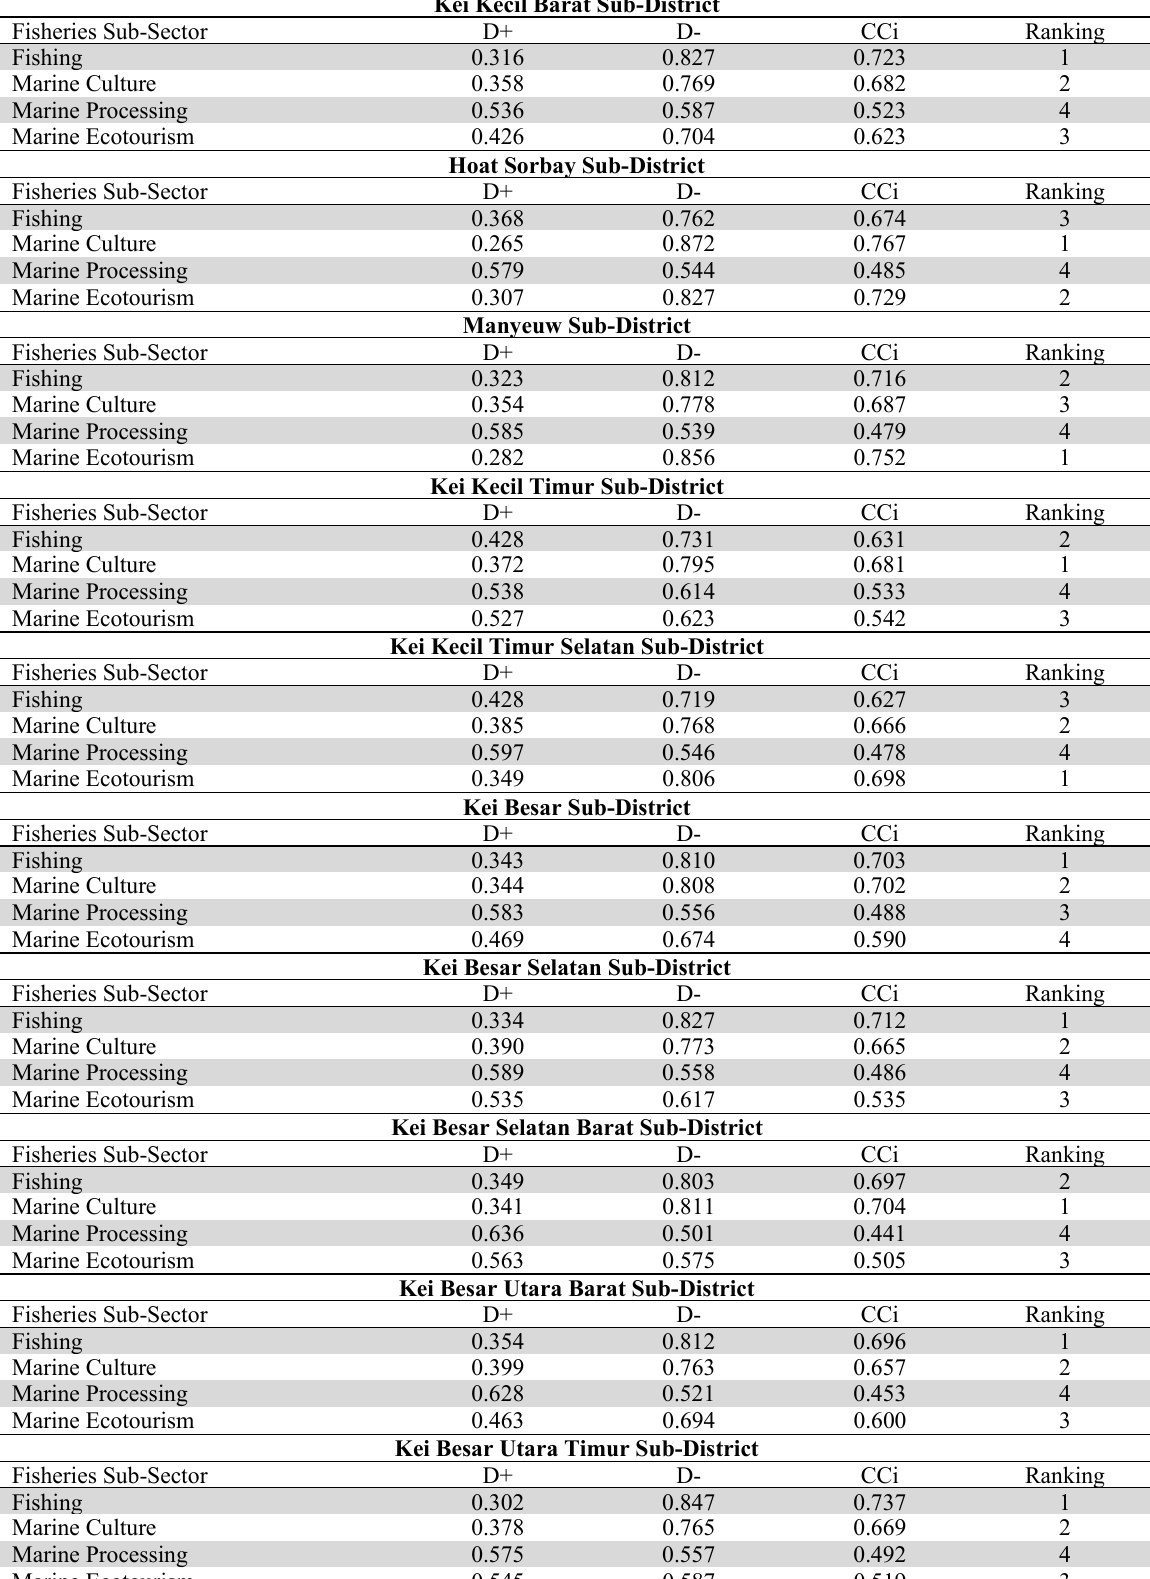
Final ranking of fisheries sub-sector for remaining sub-districts Kei Kecil Barat